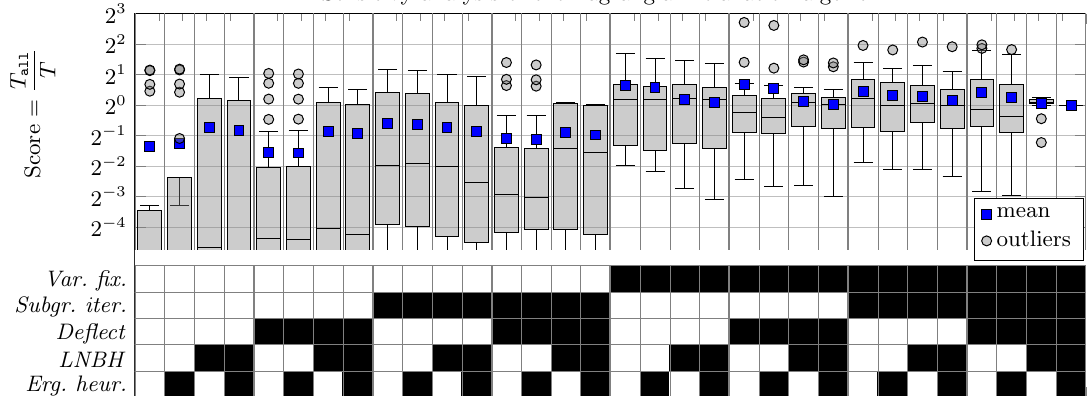
Figure 2 The impact of not using (off, white) or using a feature (on, black). T denotes each execution time on ten uncorrelated instances and ten correlated jobs instances of size m = 10 and n = 100. The score for each instance and feature is the ratio between switching all features on ( T all ) and T . The scores for the 20 instances and each feature combination are presented with boxplots (median, lower and upper quartiles, and the most extreme values in the 1 . 5 · IQR (inter-quartile range)), outliers (grey circles), and mean (blue